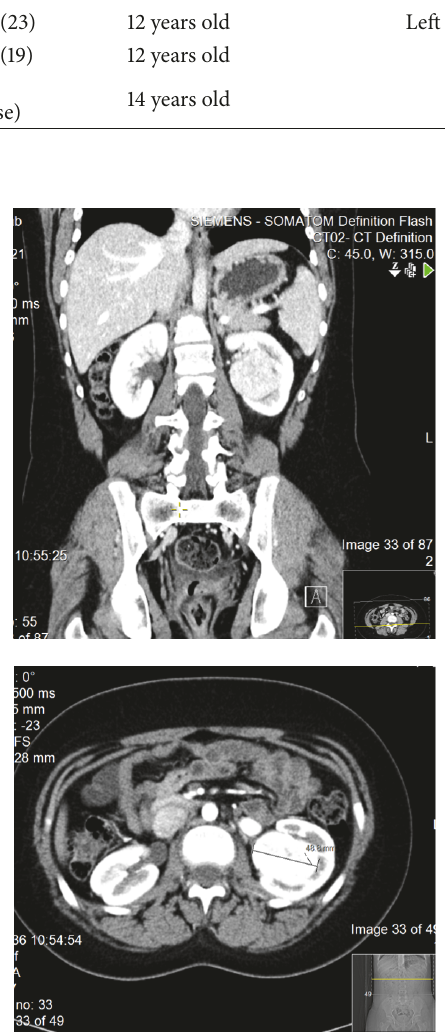
Figure 3: CT study.